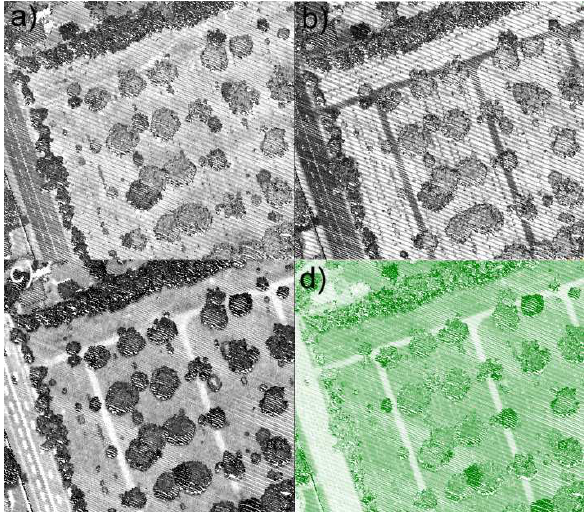
Figure 4. Contrast between sealed and unsealed classes: a) low contrast for channel C1; b) high contrast for channel C2; c) moderate contrast for channel C3 (inverse to C1 and C2); d) high contrast for the pseudo